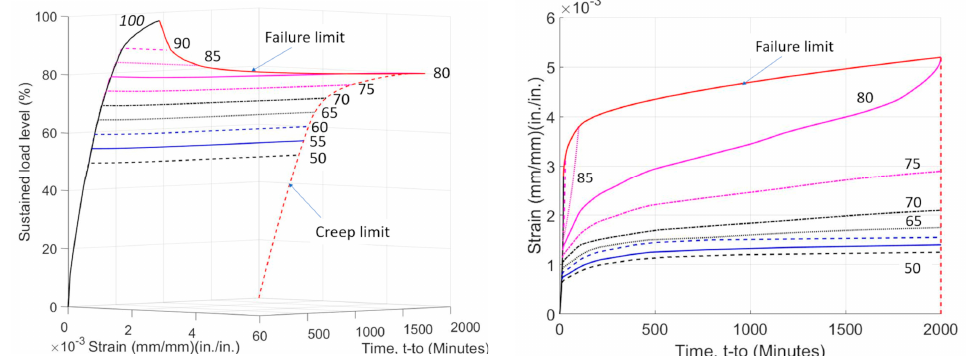
Figure 2. Effect of sustained stress level and duration on the concrete strain (adapted from Rüsch [1]).